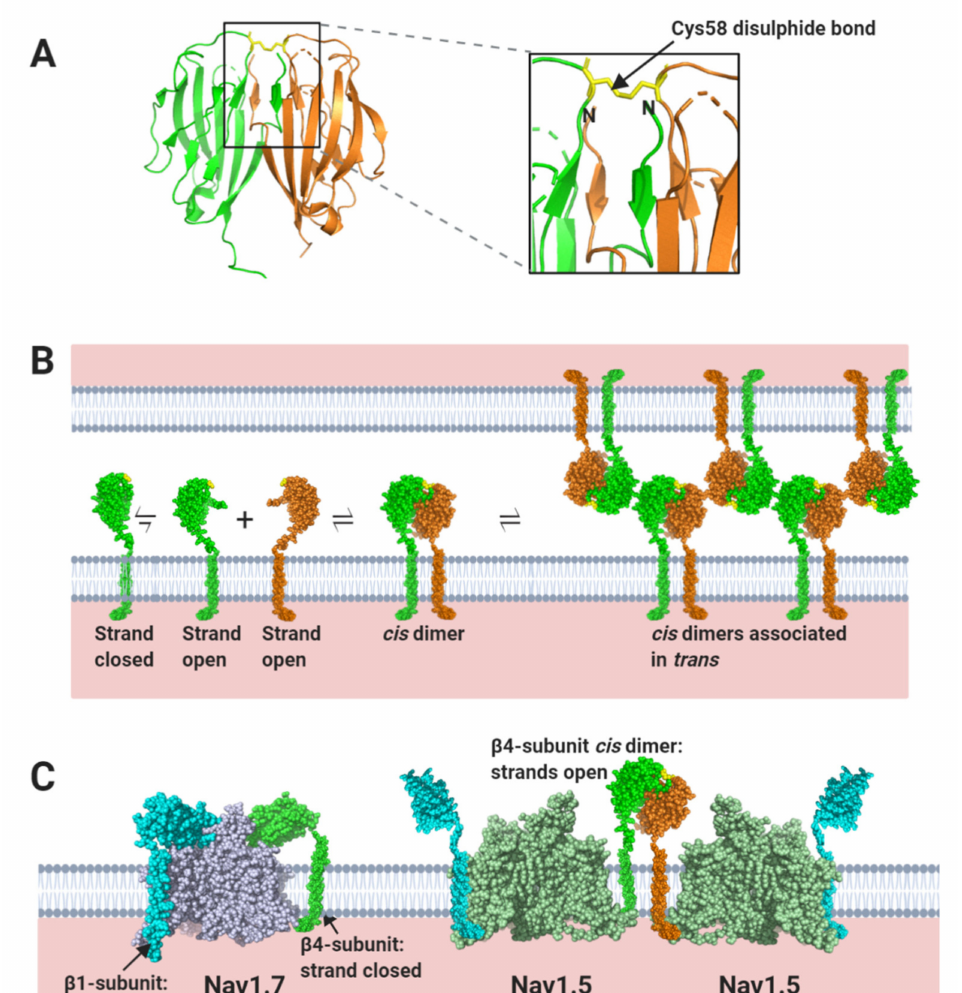
Figure 8. The β 4-subunit Ig domain can associate in both cis and trans . ( A ) The disulphide-bonded, cis -interacting, dimeric β 4-subunit Ig domain (PDB: 5XAW) with the Cys58 disulphide and the strand swap N-terminal regions highlighted. ( B ) Proposed model for trans -interacting, β 4-subunit Ig domain cis -dimers, based on the model discussed in the text [79]. ( C ) Proposed association of the β 4- and β 1-subunits on Nav1.7 and Nav1.5 α -subunits. Note, to clarify the structural details in (A) and the cartoon models in ( B ) and ( C ), the two identical β 4 Ig domains and β 4-subunits are coloured di ff erently, in green and